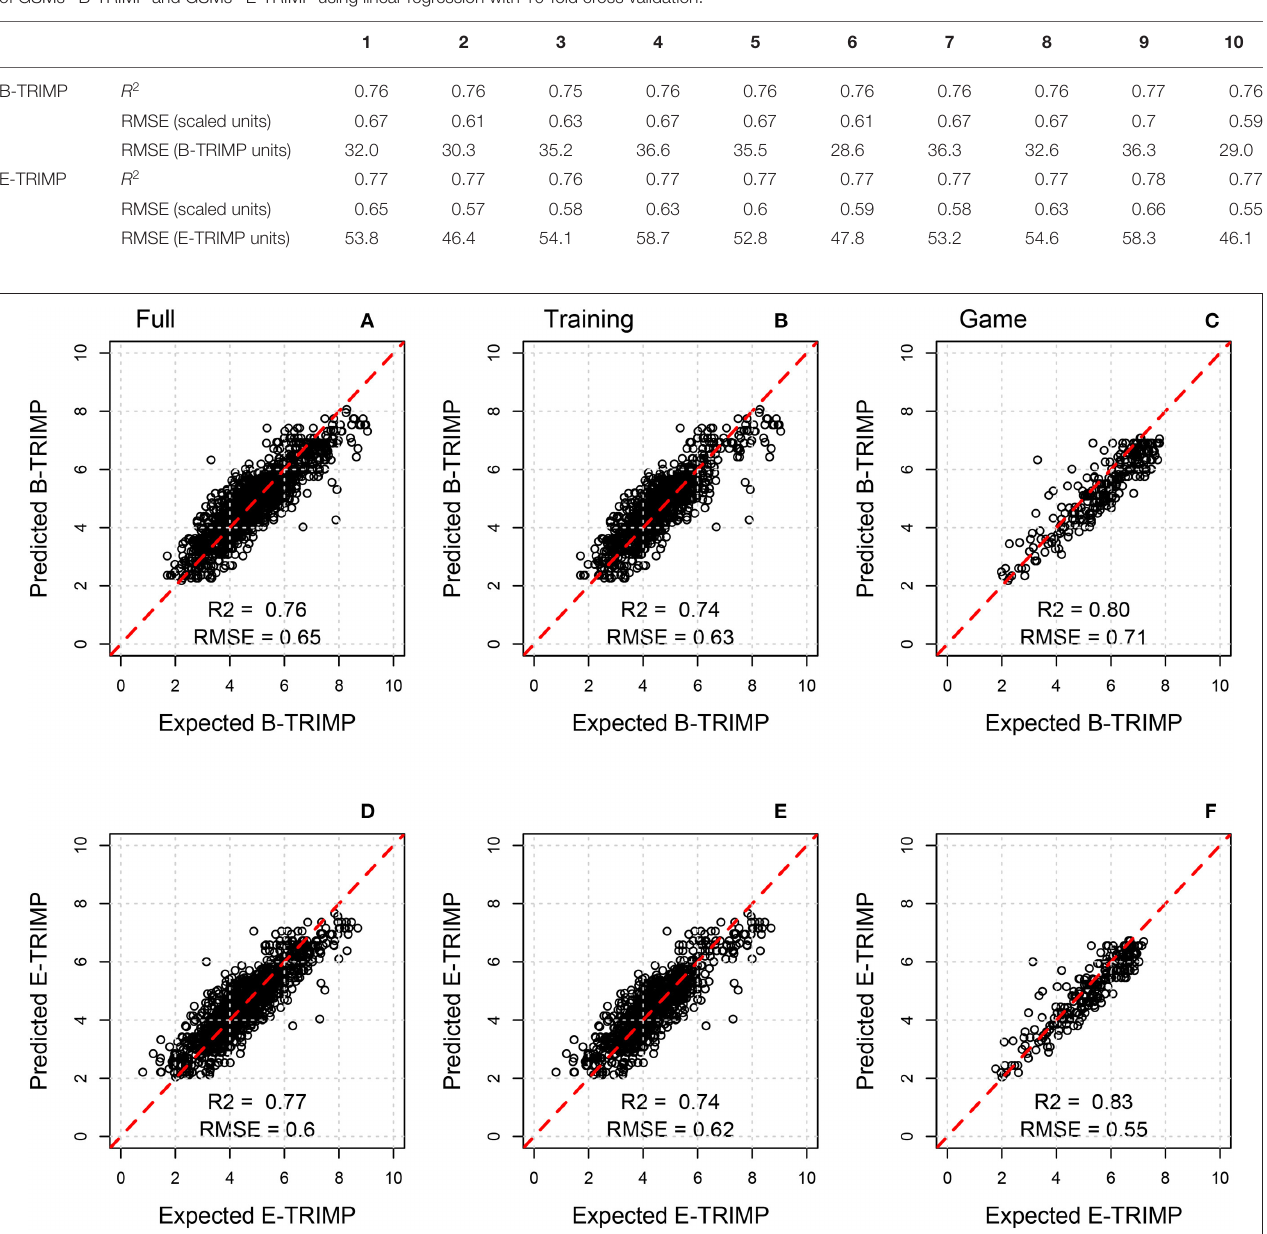
TABLE 2 | Model performance, assessed via the coefficient of determination, root mean square error (RMSE) of scaled units, and RMSE of original units for the prediction of GSMs B-TRIMP and GSMs E-TRIMP using linear regression with 10-fold cross validation. ∼ ∼